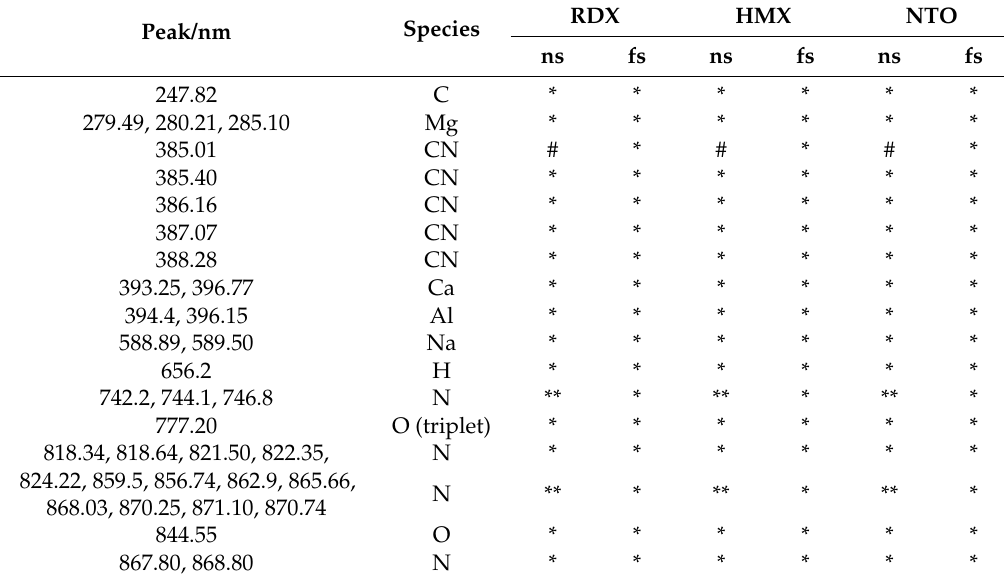
Table 2. List of various atomic and molecular peaks in the LIBS spectra of NTO, RDX, and HMX obtained using fs and ns